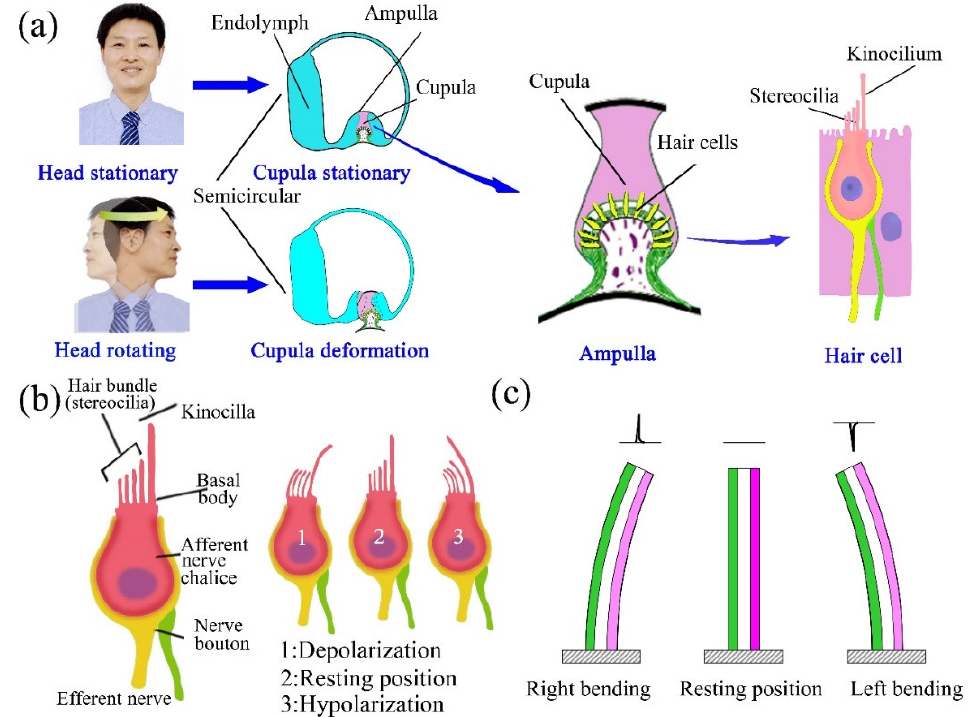
Figure 3. ( a ) A diagram of the HSCs, ampulla, and sensory hair cells. ( b ) A diagram of a hair cell to show its cilia incline direction through its state of depolarization or hyperpolarization. ( c ) A diagram of the SMPF to show its deformation direction through the generation of positive or negative charge polarity.